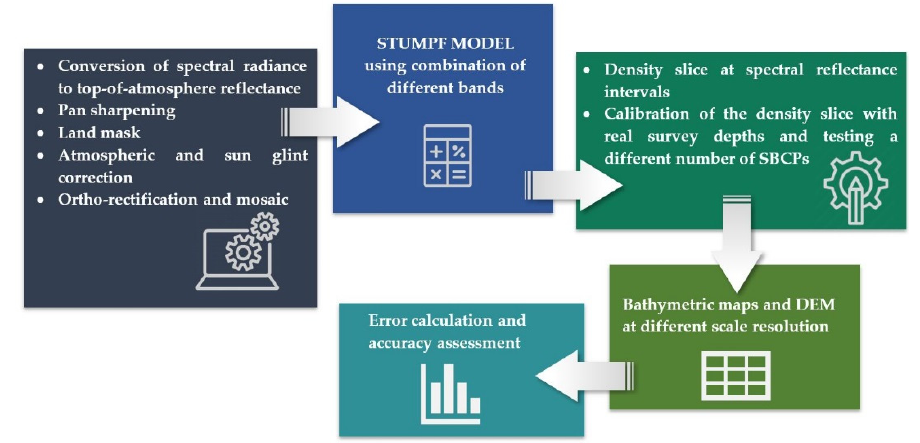
Figure 3. Satellite-Derived Bathymetry (SDB) image processing sequence.